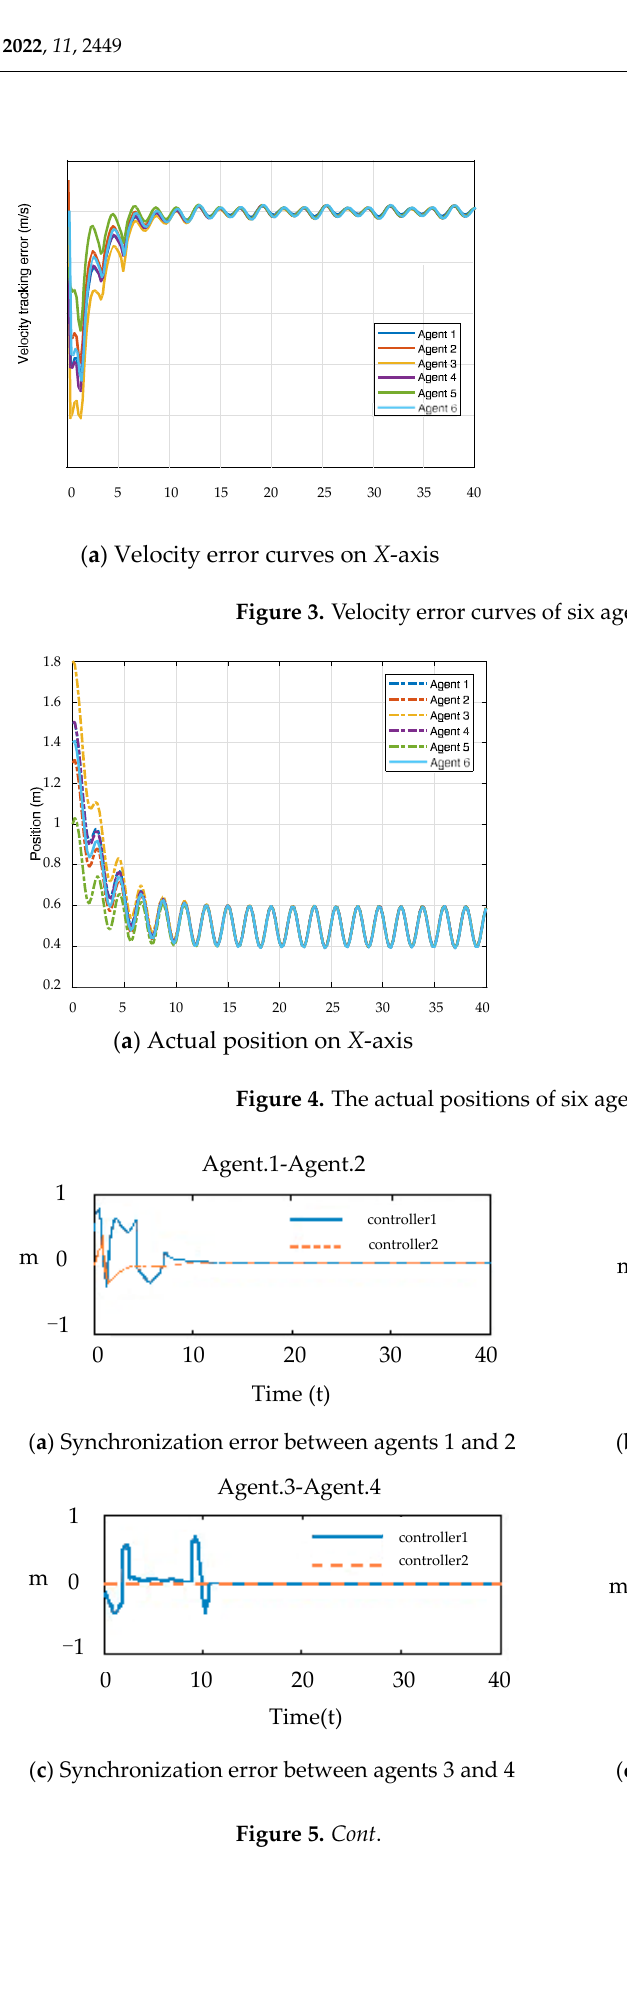
Figure 6. Kinematic parameter estimates (cid:2016)(cid:3552) (cid:3038),(cid:3036) when (cid:2016)(cid:3552) (cid:3038),(cid:3036) (0) has three different initial values. ( a ) (cid:2016)(cid:3552) (cid:3038),(cid:3036) (0) = (cid:2016)(cid:3552) (cid:3038),(cid:3036) (01) , ( b ) (cid:2016)(cid:3552) (cid:3038),(cid:3036) (0) = (cid:2016)(cid:3552) (cid:3038),(cid:3036) (02) , ( c ) (cid:2016)(cid:3552) (cid:3038),(cid:3036) (0) = (cid:2016)(cid:3552) (cid:3038),(cid:3036) (03) .